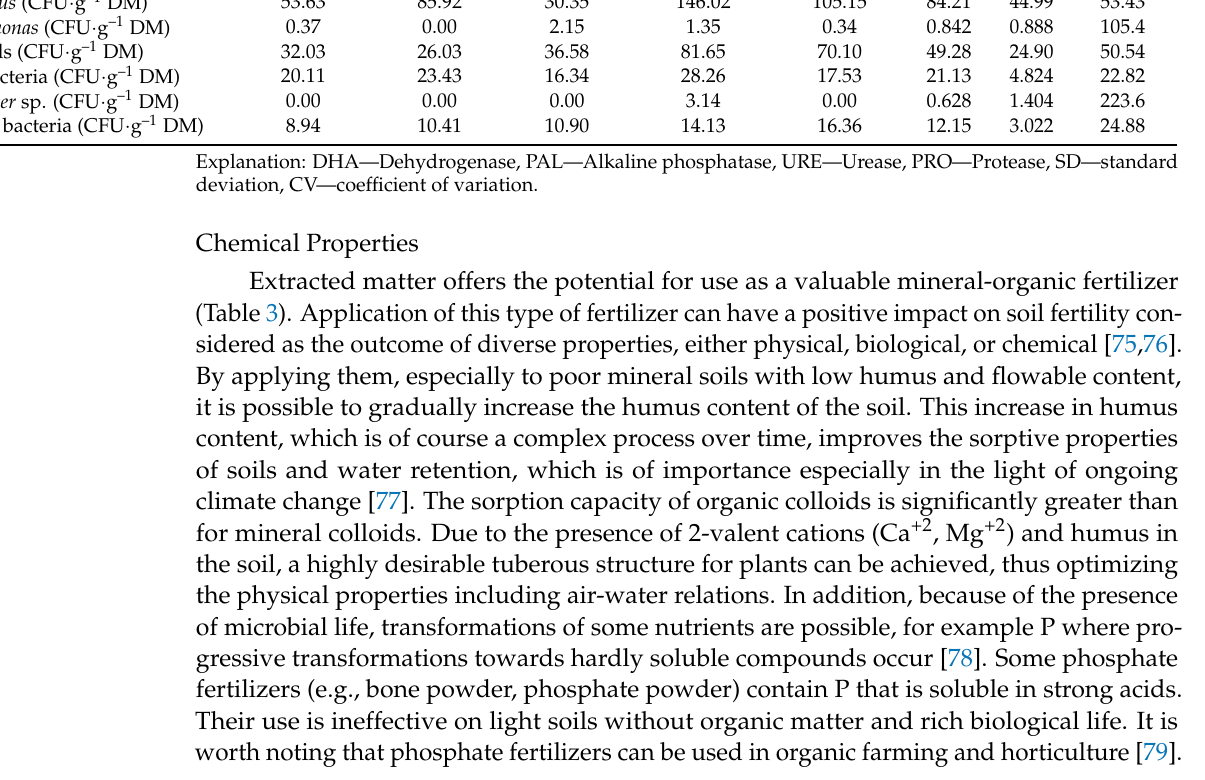
Table 3. Macronutrients and sodium content in extracted matter samples at selected sites (mg · dm − 3 ).